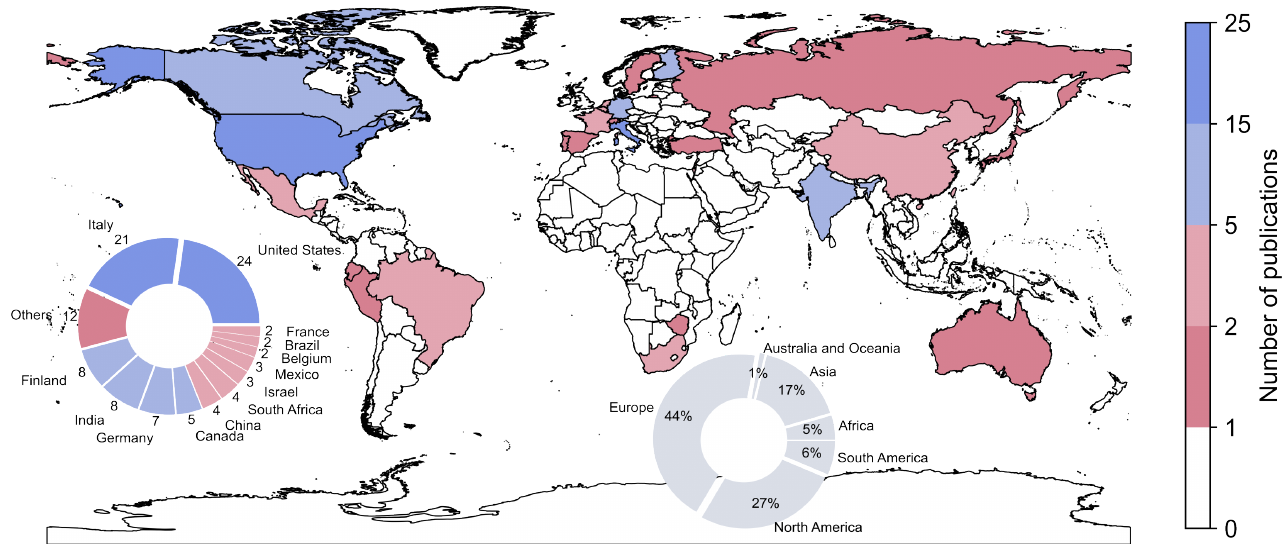
Figure 5. Map of the spatial distribution of the first author affiliations by country. The bar on the right is at categorical scale and presents five frequency classes. About 44% of all studies are from first authors with an affiliation in Europe, followed by North America (27%) and Asia (17%). At country level, most first authors have their affiliation in the United States (24 publications), followed by Italy (21 publications). The class “Others” aggregates all countries with a single